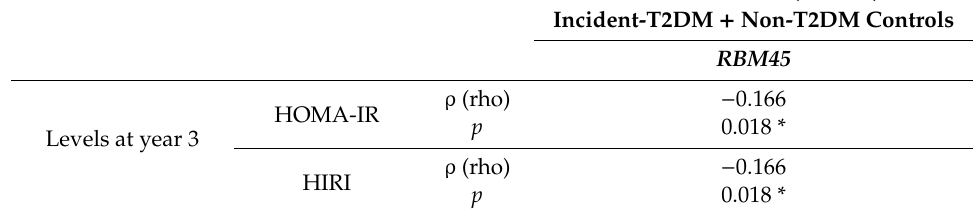
Table 2. Correlations between the expression levels of RBM45 and relevant T2DM related parameters at year 3 in the total study population (Incident-T2DM + non-T2DM controls n = 215).